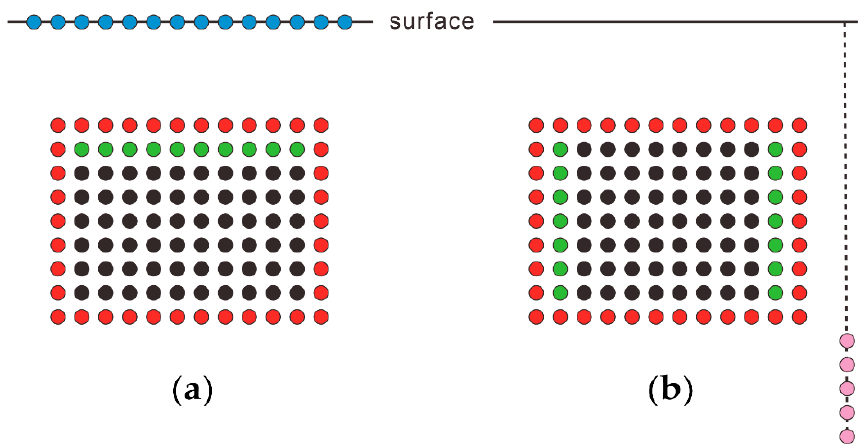
Figure 6. Schematics of the location of the virtual receivers in the local FWI based on the standard Marchenko receiver redatuming ( a ) and the VSP-driven local FWI ( b ). The internal part of the area surrounded by the rectangle of red dots is the target zone. The red dots represent the virtual source points x vs , the green dots are the virtual receiver points x vr ( a ) and x vsp vr ( b ), the blue dots are the physical surface sources x s , and the pink dots are the subsurface VSP receivers x vsp . The black dots are other grid points within the target volume.